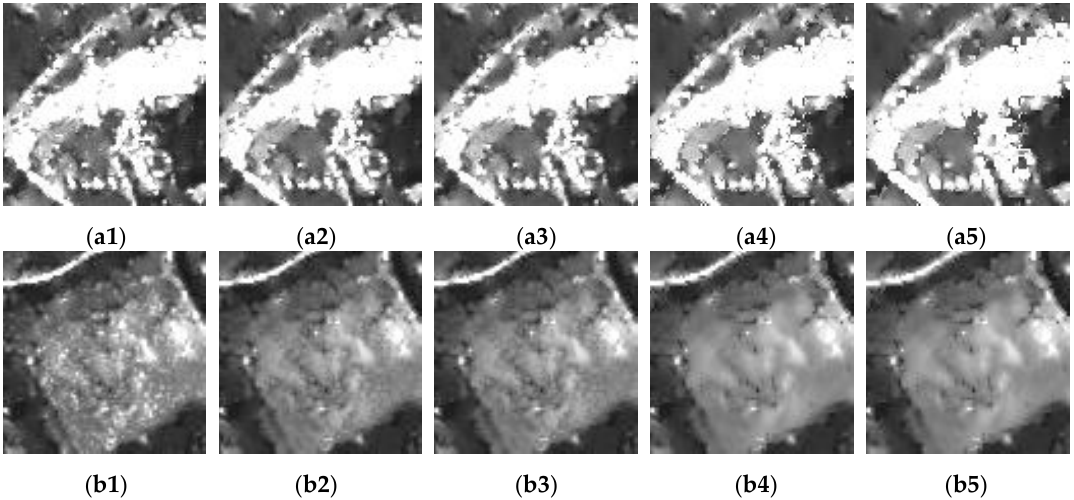
Figure 7. Impact of n in Equation (12) on the speckle suppression and correction for the spreading of bright structures. There are two groups of experimental results: ( a1 ) to ( a5 ) and ( b1 ) to ( b5 ). For ( a1 ) and ( b1 ), n is set to 1. And for the second, third, fourth, and fifth columns, the values of n are 5, 10, 20 and 50, respectively.